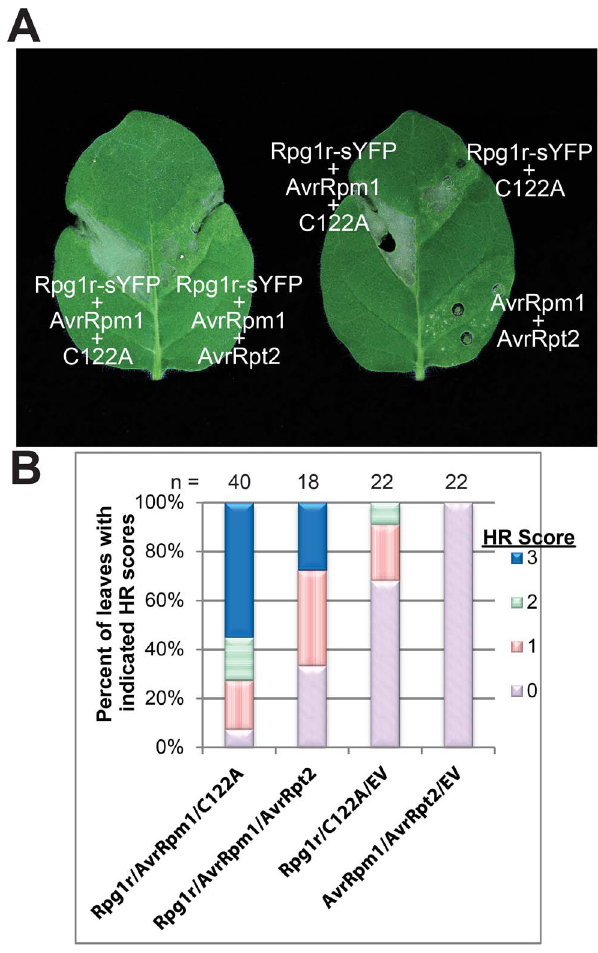
Figure 3. Reconstituting the Rpg1r -mediated defense pathway in N. glutinosa . ( A ) Rpg1r - sYFP -mediated HR does not require co- expression of a GmRIN4 gene, but is suppressed by avrRpt2 . The images shown are of typical responses displayed by N. glutinosa leaves expressing the combination of genes labeled on each image. ( B ) Quantification of Rpg1r - sYFP mediated HR. Responses were categorized as described in Figure 2. C122A indicates the protease inactive form of AvrRpt2. Images were taken and plant leaves were scored approxi- mately 2 days after transgene induction. The number of leaves infiltrated and scored for each combination (n) is listed above each bar. This experiment was repeated 3 times with similar results.